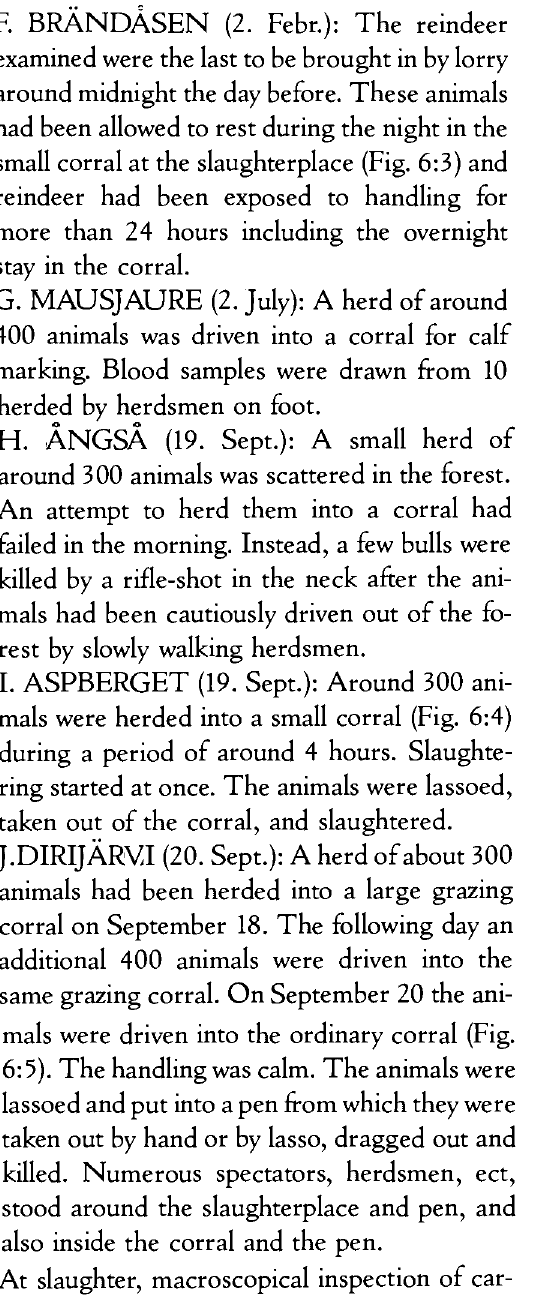
Fig. 6. The construction and shape of the corrals used for the different herds